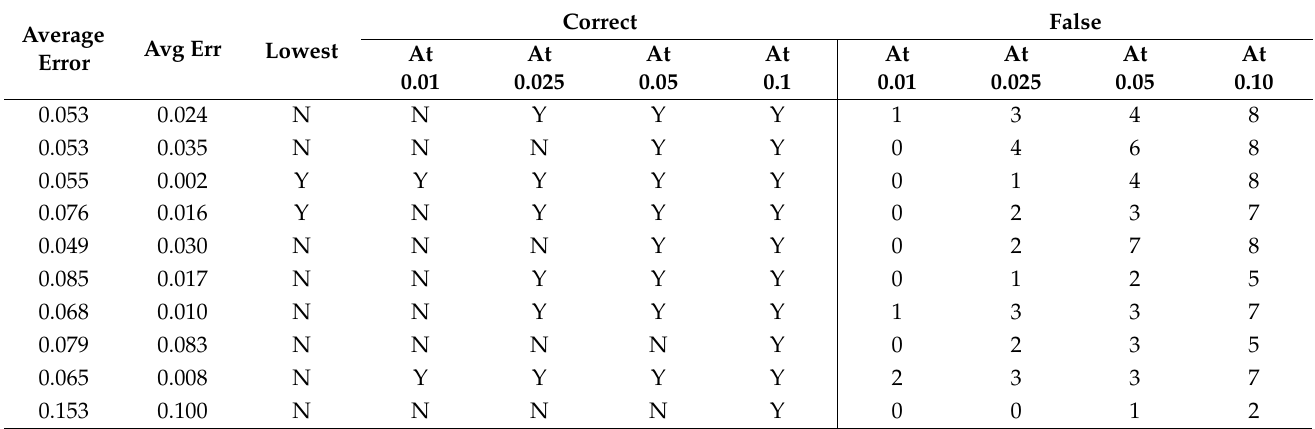
Table A44. Set 1, trials 21–30 summary data (single 0.5 PR value).